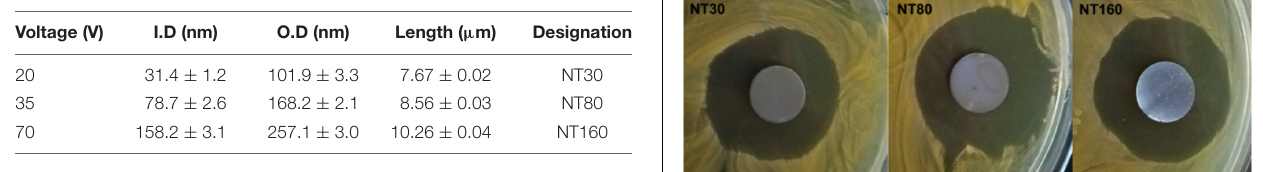
TABLE 1 | TiO 2 nanotubes’ diameter, length, and sample designation.